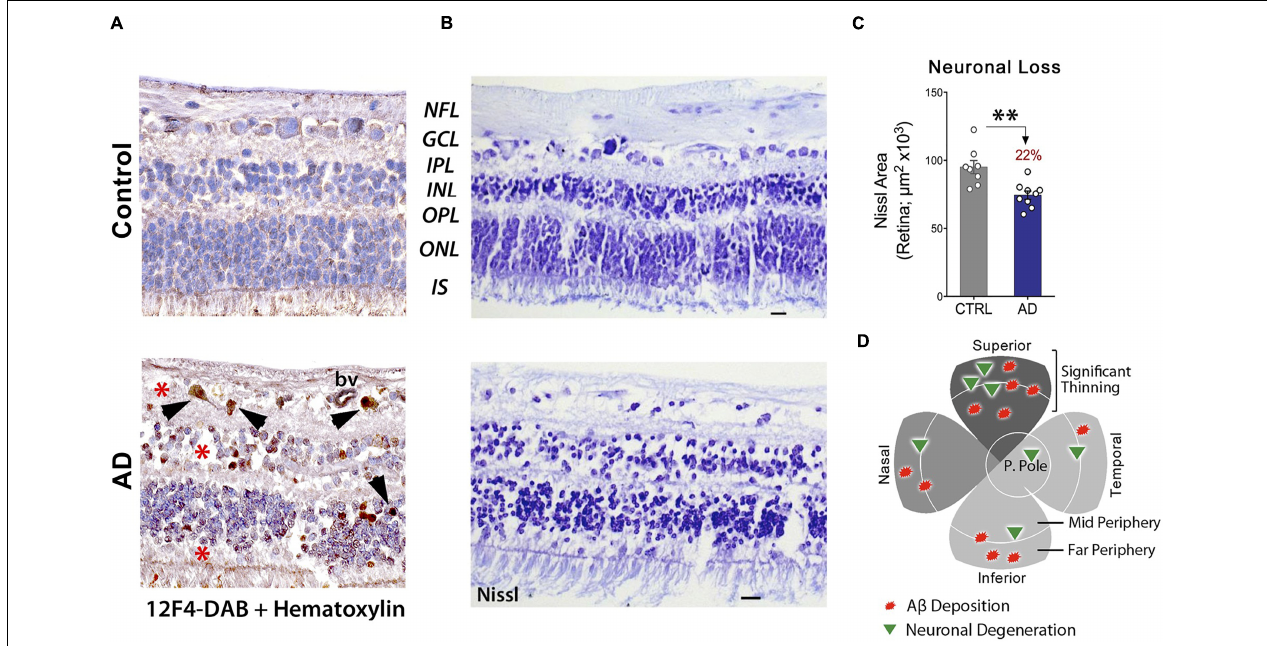
FIGURE 5 | Increased A β 42 -associated neuronal loss in post-mortem retinas of AD patients. (A) Representative images of post-mortem retinal cross-sections from CN and AD cases, immunostained with anti-A β 42 mAb (12F4) and labeled with peroxidase-based DAB (brown) and hematoxylin counterstain (violet). Intracellular A β 42 -inclusions are observed in GCL, INL and ONL of AD retina. Scale bars: 20 µ m. (B) Nissl staining of retinal cross-sections from a control subject and AD patient, revealing cellular and retinal layer alterations in AD. (C) Quantitation of neuronal Nissl-positive total area in retinas of AD patients ( n = 9) compared to age-/sex-matched CN control subjects ( n = 8). Data shown as group mean ± SEM. ** P < 0.01, unpaired 2-tailed Student’s t -test (D) Qualitative geometric map of increased retinal A β deposits (red shapes) and neuronal loss (green triangles) in AD patients. Panels a-c are reproduced from Koronyo et al. (2017) with permission of ASCI via Copyright Clearance Center. Panel d is adapted from Hart et al. (2016) under terms of the Creative Commons Attribution 4.0 International License